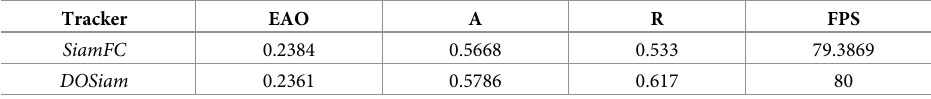
Table 4. Comparison with SiamFC on VOT2019-RGBT(TIR) in terms of EAO, A, R and FPS. Tracker EAO A R FPS SiamFC 0.2384 0.5668 0.533 DOSiam